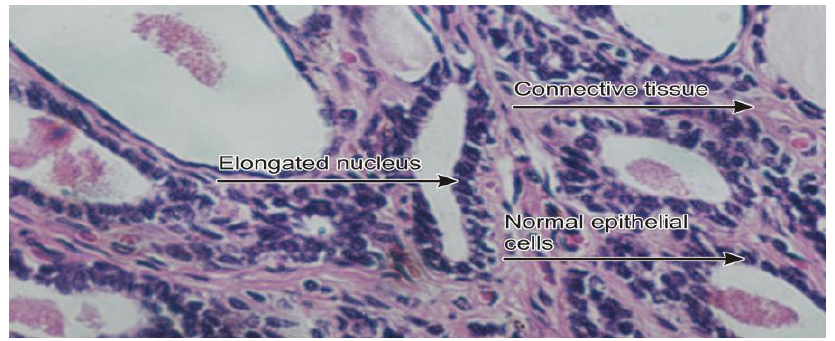
Figure – 4: Cross section from seminal vesicle of castrated treated rat showing elongated nucleus with mucus in the lumen ( H&E stain,